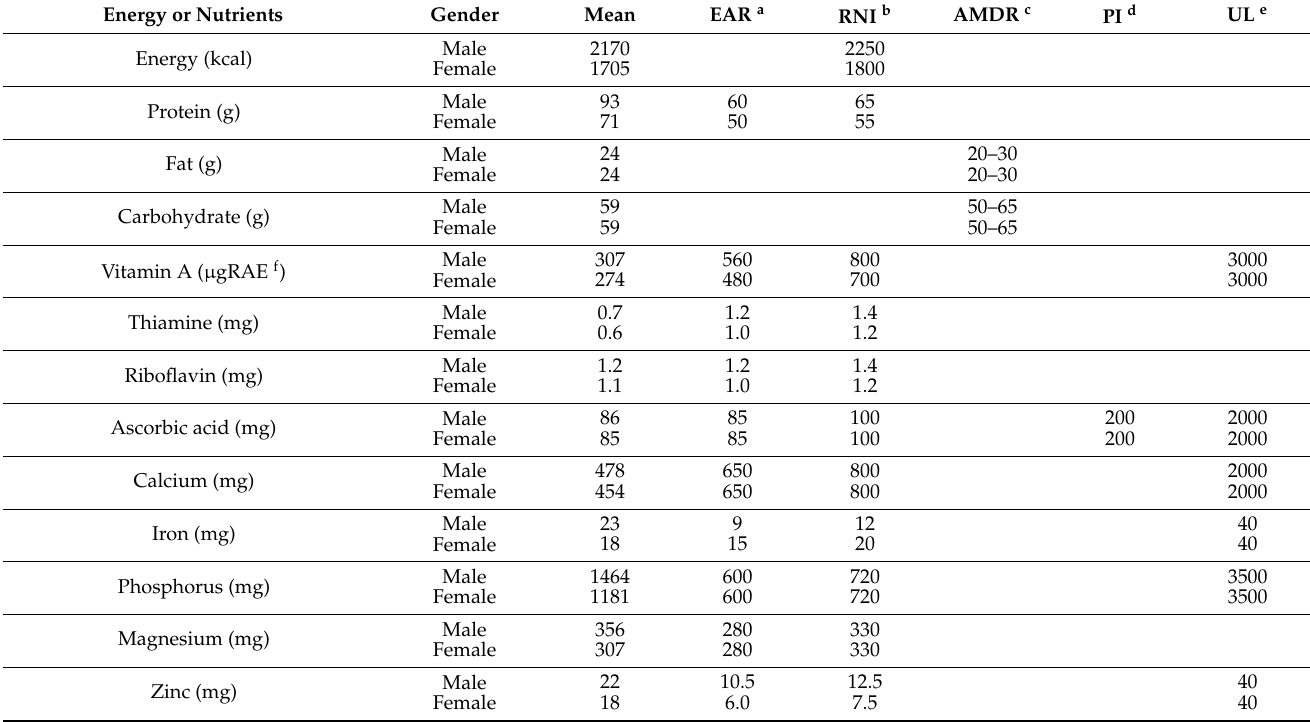
Table 5. The average daily nutrient intake compared with the levels of DRIs (DRIs: Dietary Reference